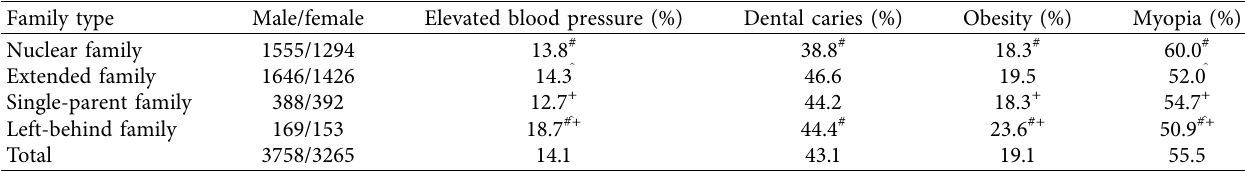
Table 2: Trends of elevated blood pressure, dental caries, obesity, and myopia among Chinese children and adolescents by different family types.